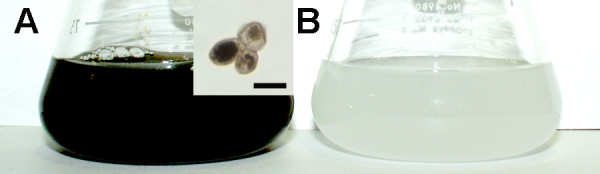
W. dermatitidis strain wdpks1Δ-1 after growth for 10 days in a defined chemical medium with [A] and without [B] L-DOPA. The inset with light microscopy in [A] depicts particles isolated from the culture after serial treatment with enzymes, denaturant, and hot acid; scale bar, 5 μm.